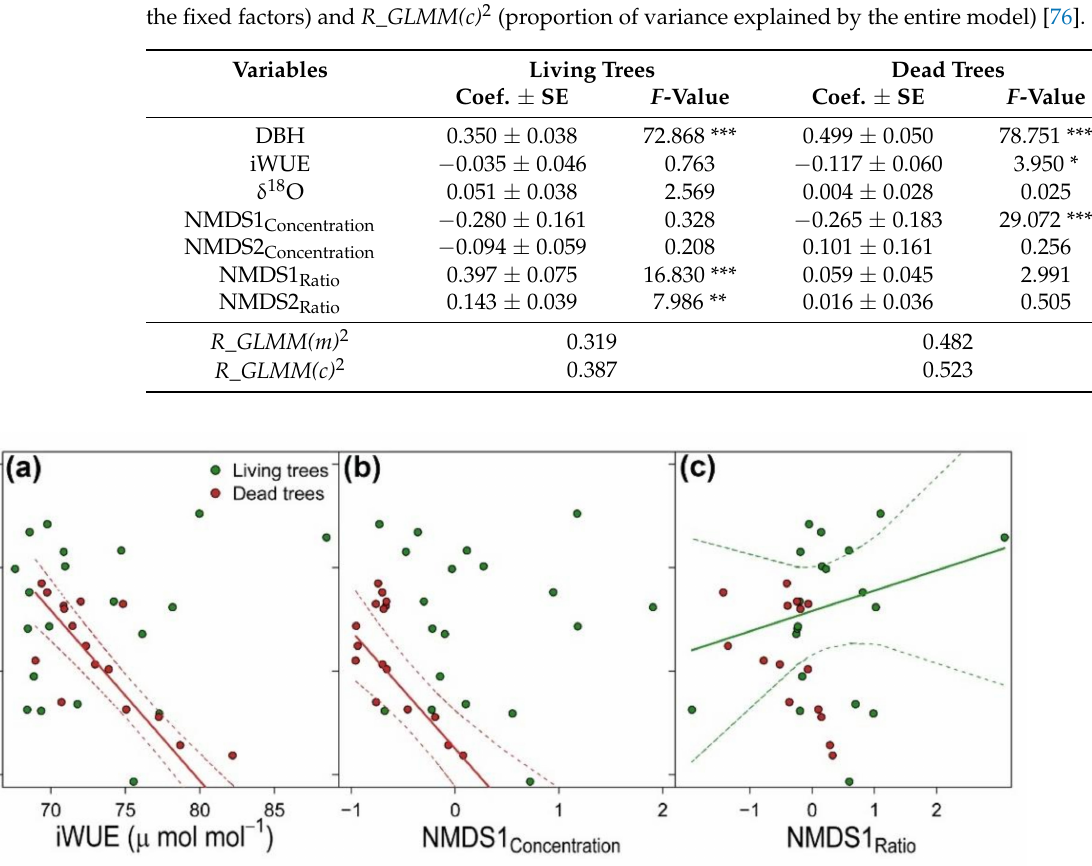
Figure 7. Relationships between basal area increment (BAI) and ( a ) intrinsic water-use efficiency (iWUE), ( b ) NMDS1 of nutrient concentration ordination and ( c ) NMDS1 of stoichiometric ratios ordination in living (green symbols and lines) and dead (red symbols and lines) Nothofagus dombeyi trees. Solid lines represent predicted relationships by linear mixed-effects models (see Table 3) and dash lines are 95% confidence